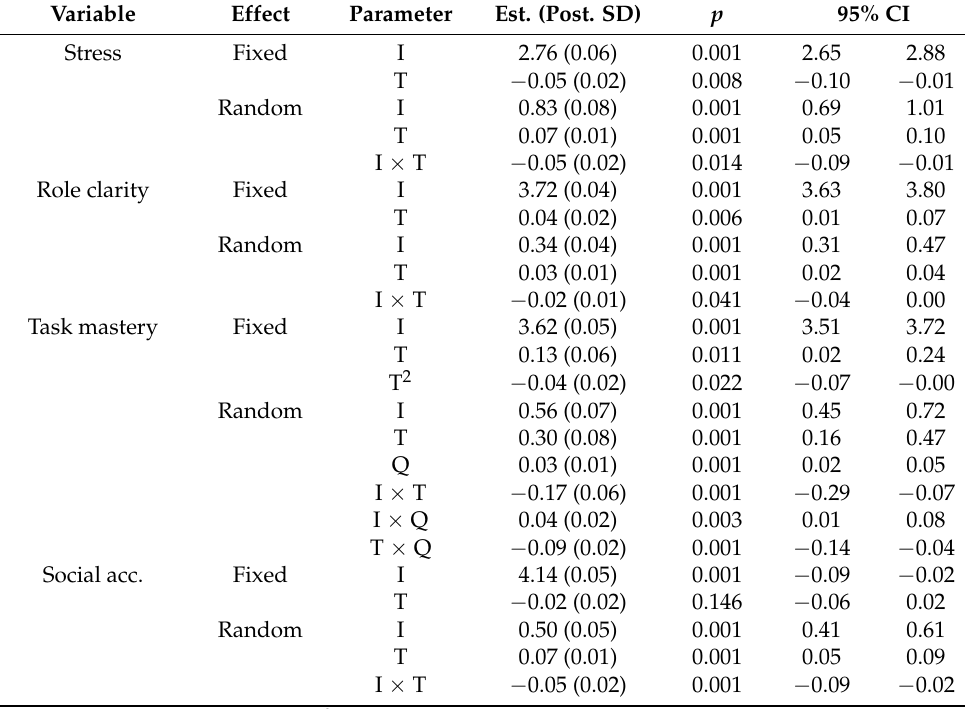
Table 3. Linear growth curve models showing development over time ( n =